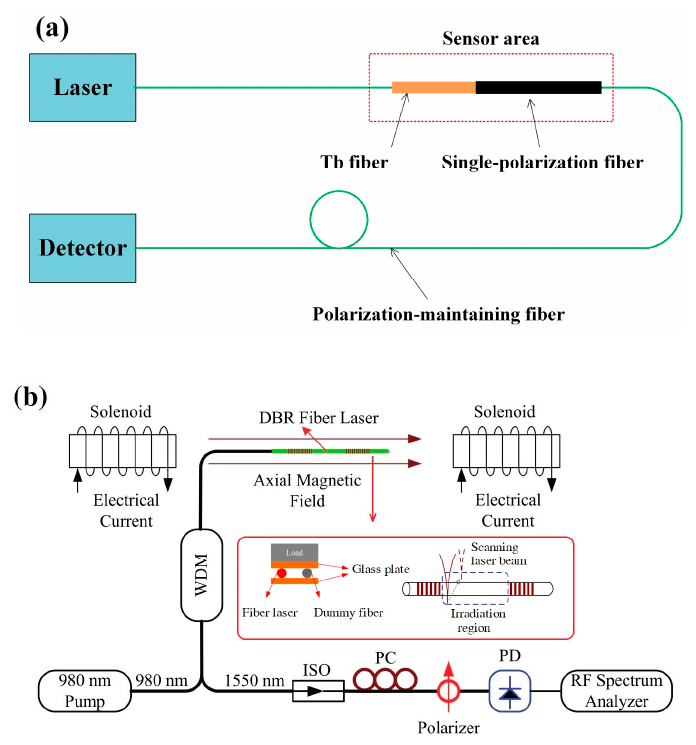
Figure 1. ( a ) Sensing system of a magneto-optic fiber magnetic-field sensor [15] (Copyright © 2010 OSA, Reprinted with permission) and ( b ) sensing system based on the heterodyning fiber grating laser [19] (Copyright © 2013 OSA, Reprinted with permission).